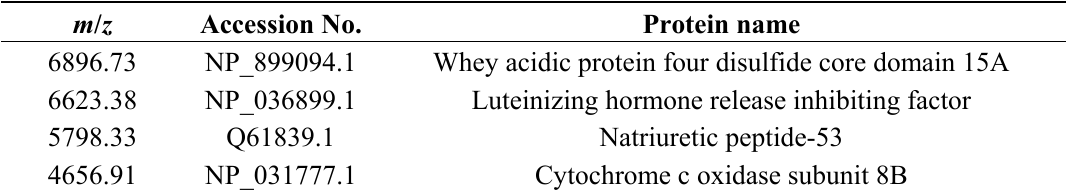
Table 2. Differentially expressed proteins identified by